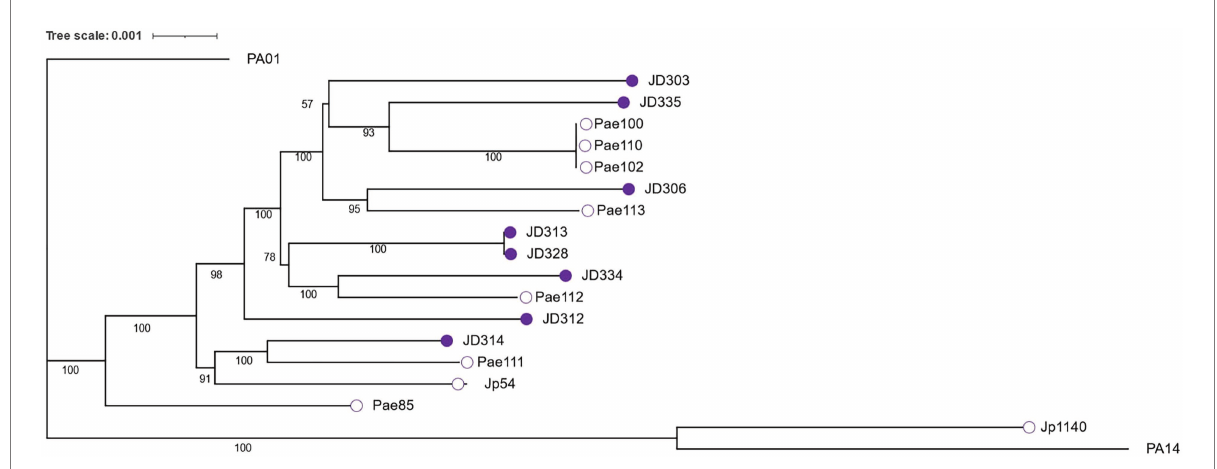
FIGURE 1 Maximum likelihood phylogeny constructed from the alignment of 3,606 core genes and visualized with iTOL (Letunic and Bork, 2021). Bootstrap values (50%–100%) for internal branches are indicated in black. Empty circles depict environmental strains while shaded purple circles depict clinical